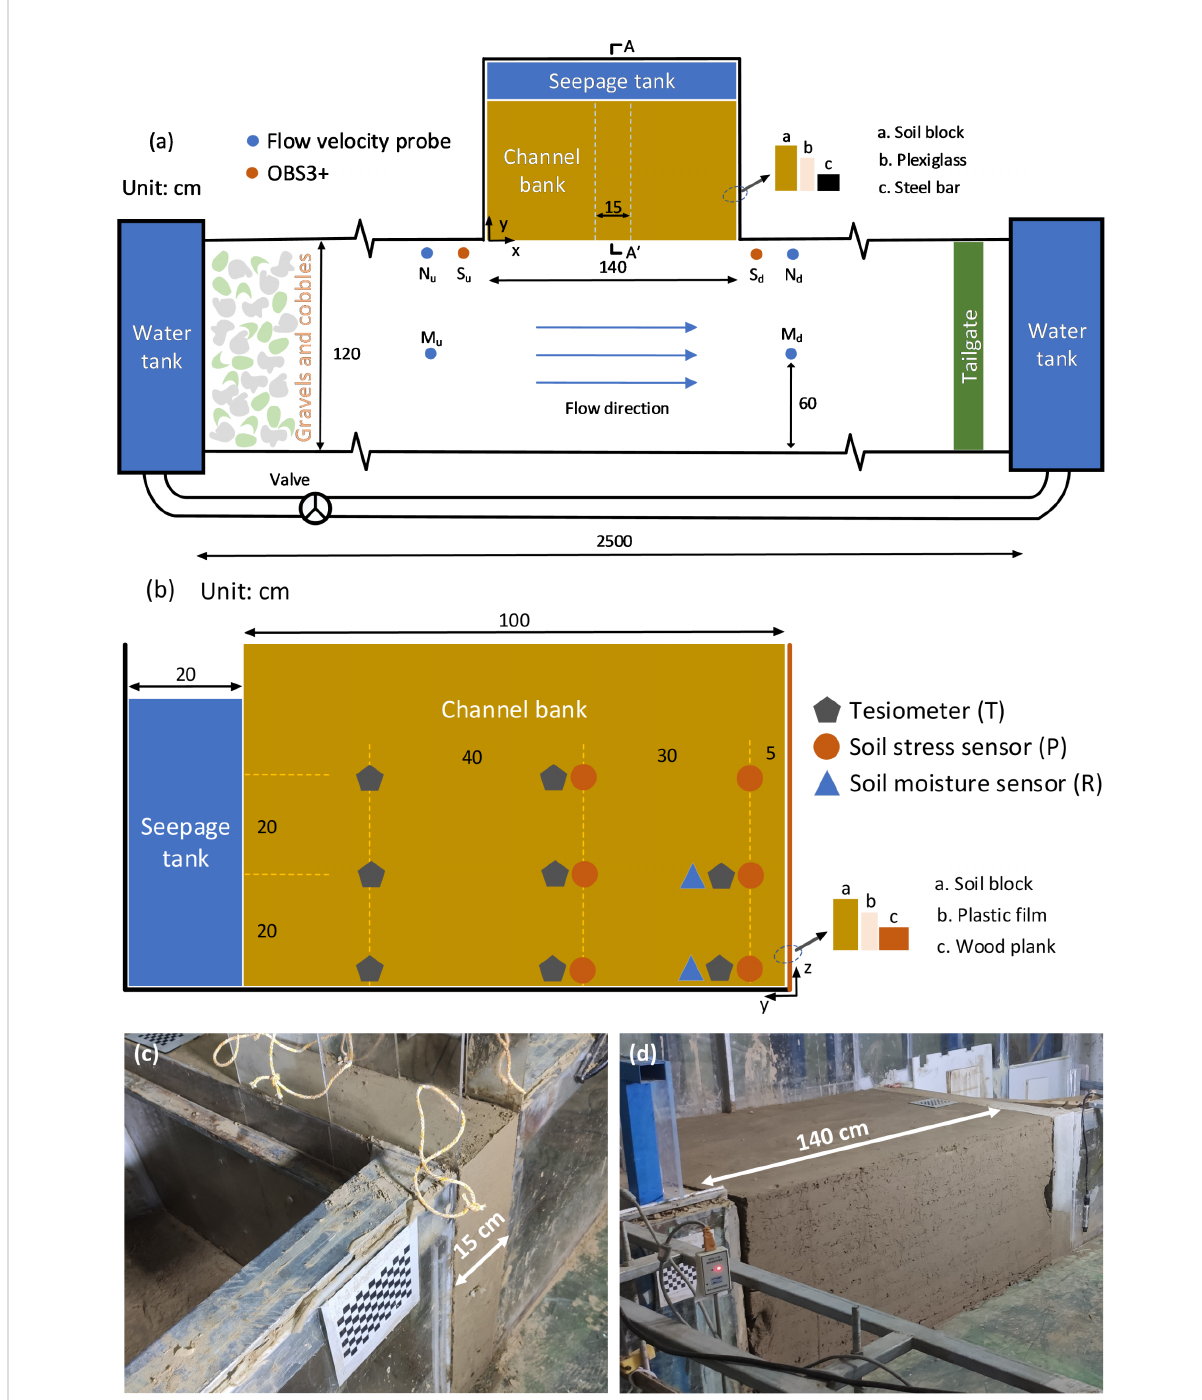
FIGURE 2 Experimental setup: (A) top view of the fl ume showing the position of the bank, the fl ow velocity probes, and the Optical Back Scatterings (OBSs); (B) lateral view of the simulated bank (A-A ’ cross section in panel (A) , showing the position of tensiometers, soil stress, and soil moisture sensors; (C) 2D channel bank; (D) 3D channel bank. Detailed position of tensiometers, stress and soil moisture sensors, fl ow velocity probes, and the OBSs is summarized in Table